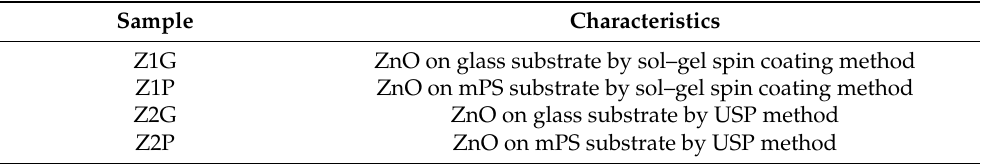
Table 1. Summary of samples